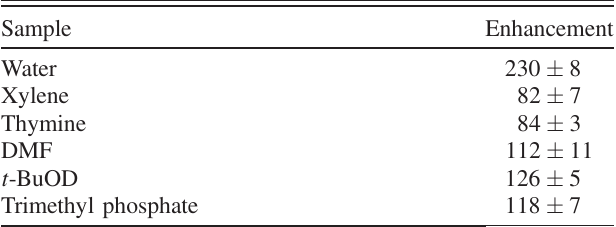
TABLE I. Summary of observed Overhauser DNP signal enhancements for small organic molecules. Error bars represent standard deviation ( 1 σ ) of CASR signals measured across three independent experiments. These molecules cover a broad chemi- cal space, including aromatic protons; aliphatic protons; vinylic protons; protons in functional groups; and protons attached to